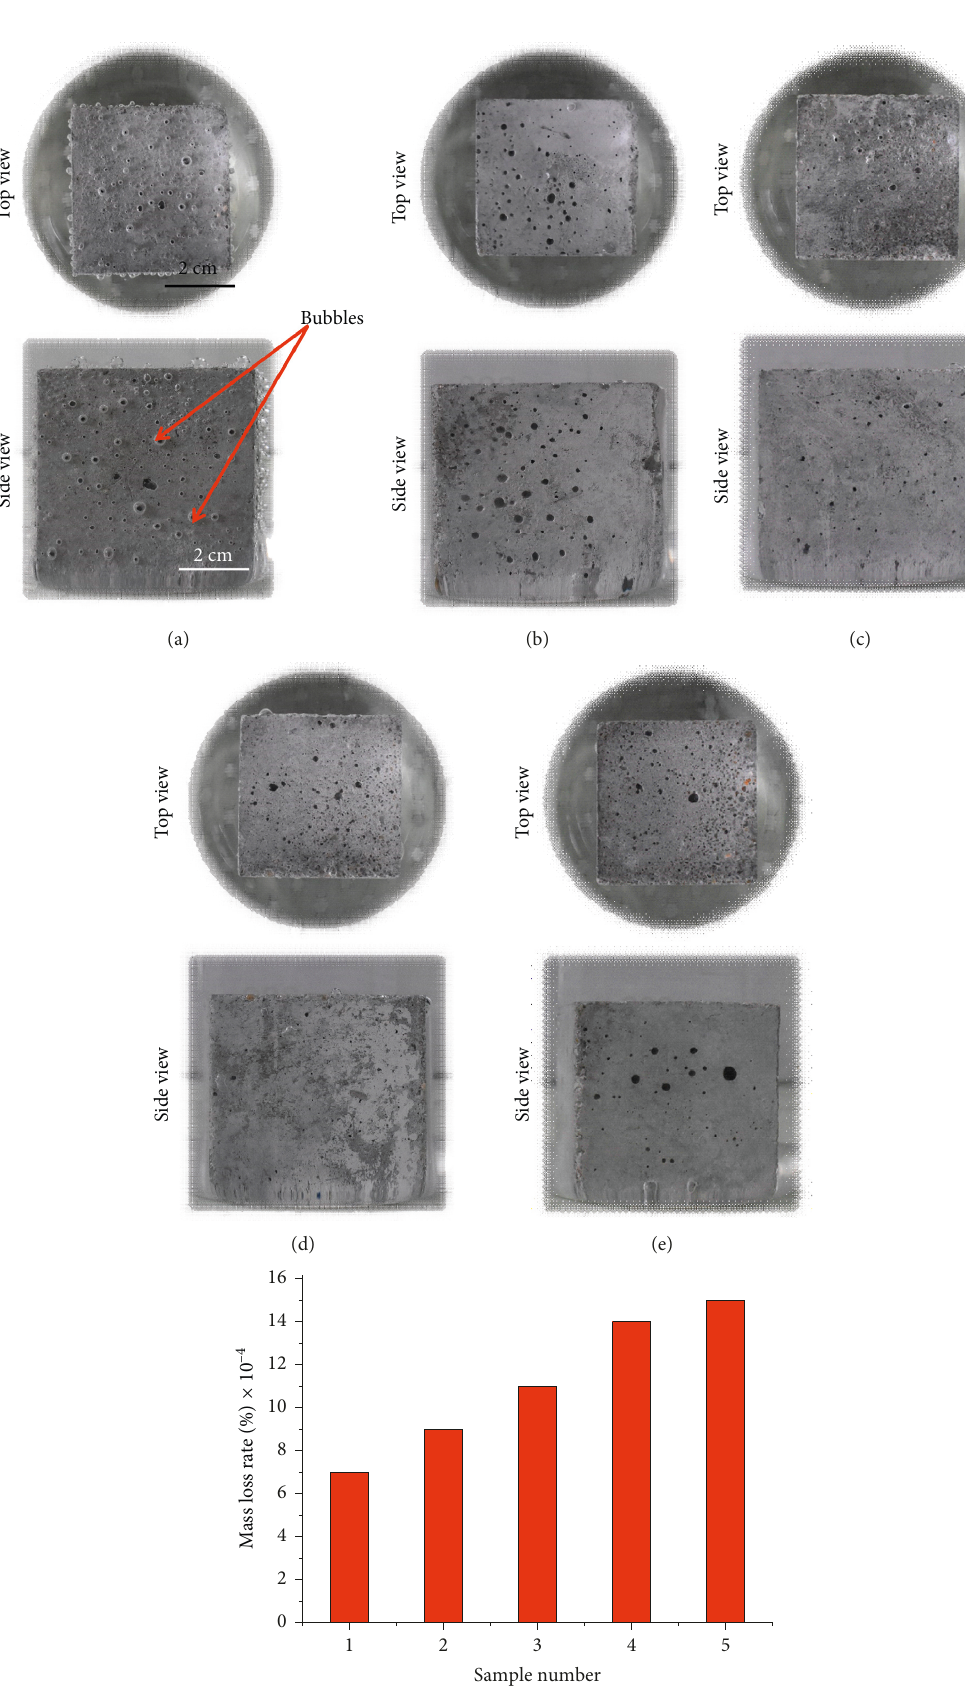
Figure 6: Photograph of the mortar block immersed in water: (a) contrast sample and (b) hydrophobic sample and after abrasion with 240- grit sandpaper for (c) 0.3mm, (d) 5.3mm, and (e) 10.4 km. (f) Mass loss rate after